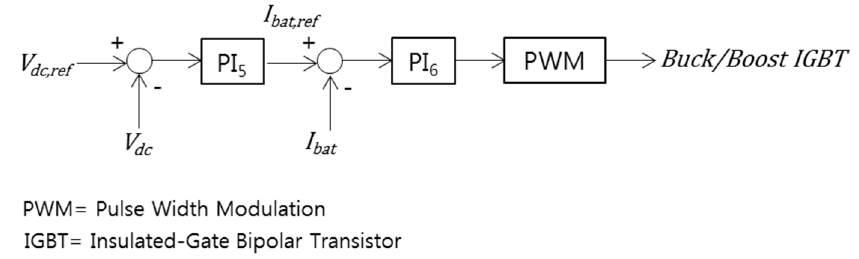
Figure 13. Control scheme of the battery converter.